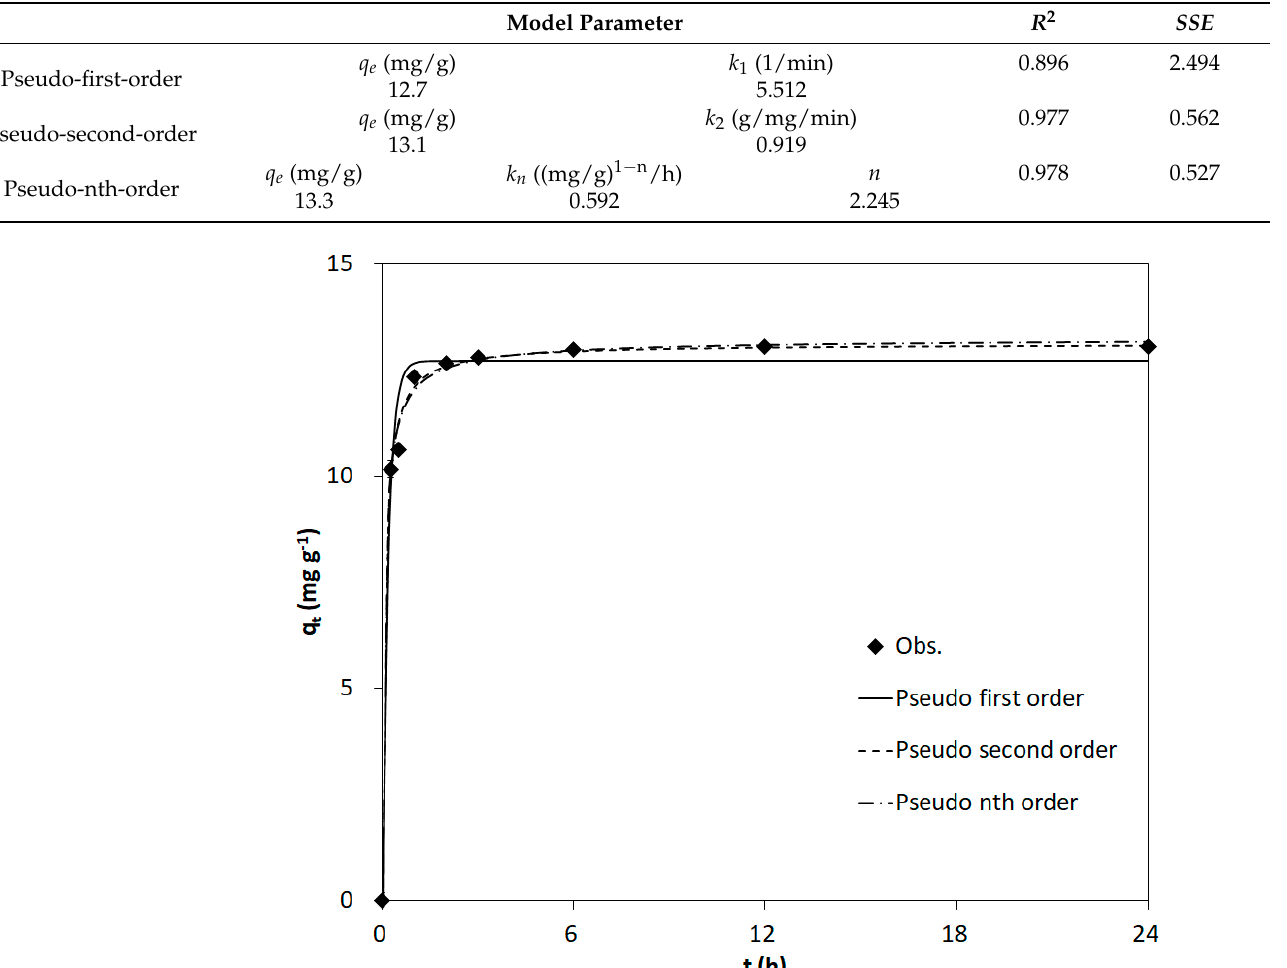
Figure 3. Kinetic adsorption results of Sb(V) adsorption by Fe-CMB and model fits using pseudo- first-order, pseudo-second-order, and pseudo-nth-order models.